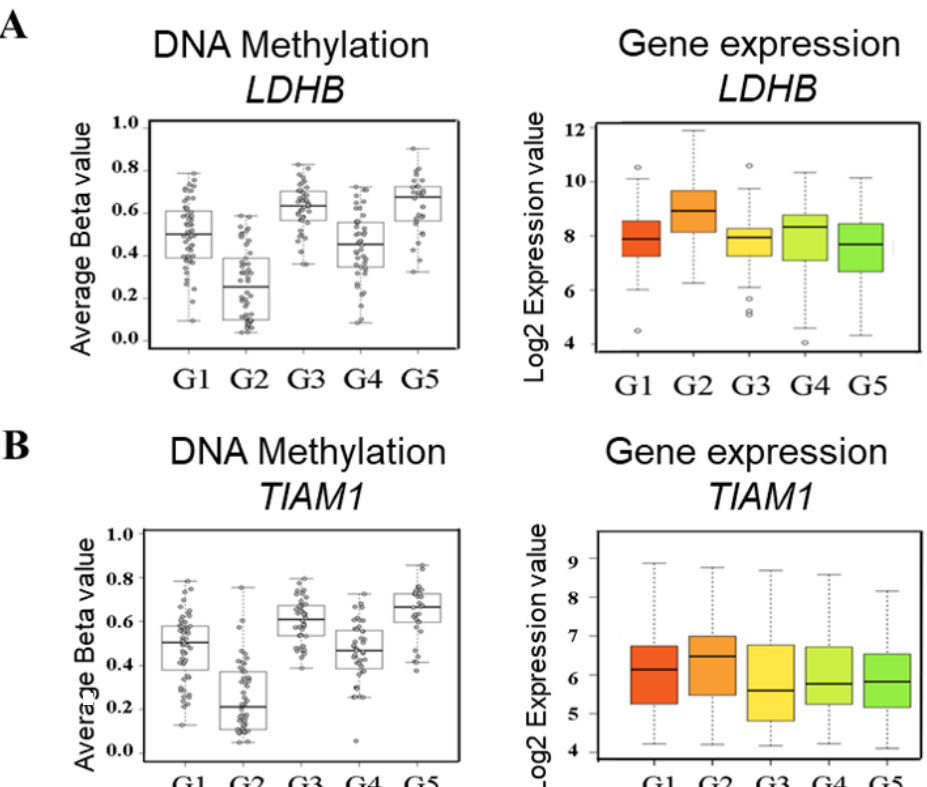
Figure 2. DNA methylation and gene expression of LDHB ( A ) and TIAM1 ( B ) genes in primary HCC patients. G1–G5 refers to HCC subgroups 1–5. Box plots for DNA methylation represent average of beta values for CpG sites identified as the region of maximal difference within DMR corresponding to the indicated gene. Beta value 1.0 is equivalent to 100% methylation, and 0.0 is equivalent to 0% methylation. Box plots for gene expression represent log2 transcript levels of the indicated gene in HCC subgroups.